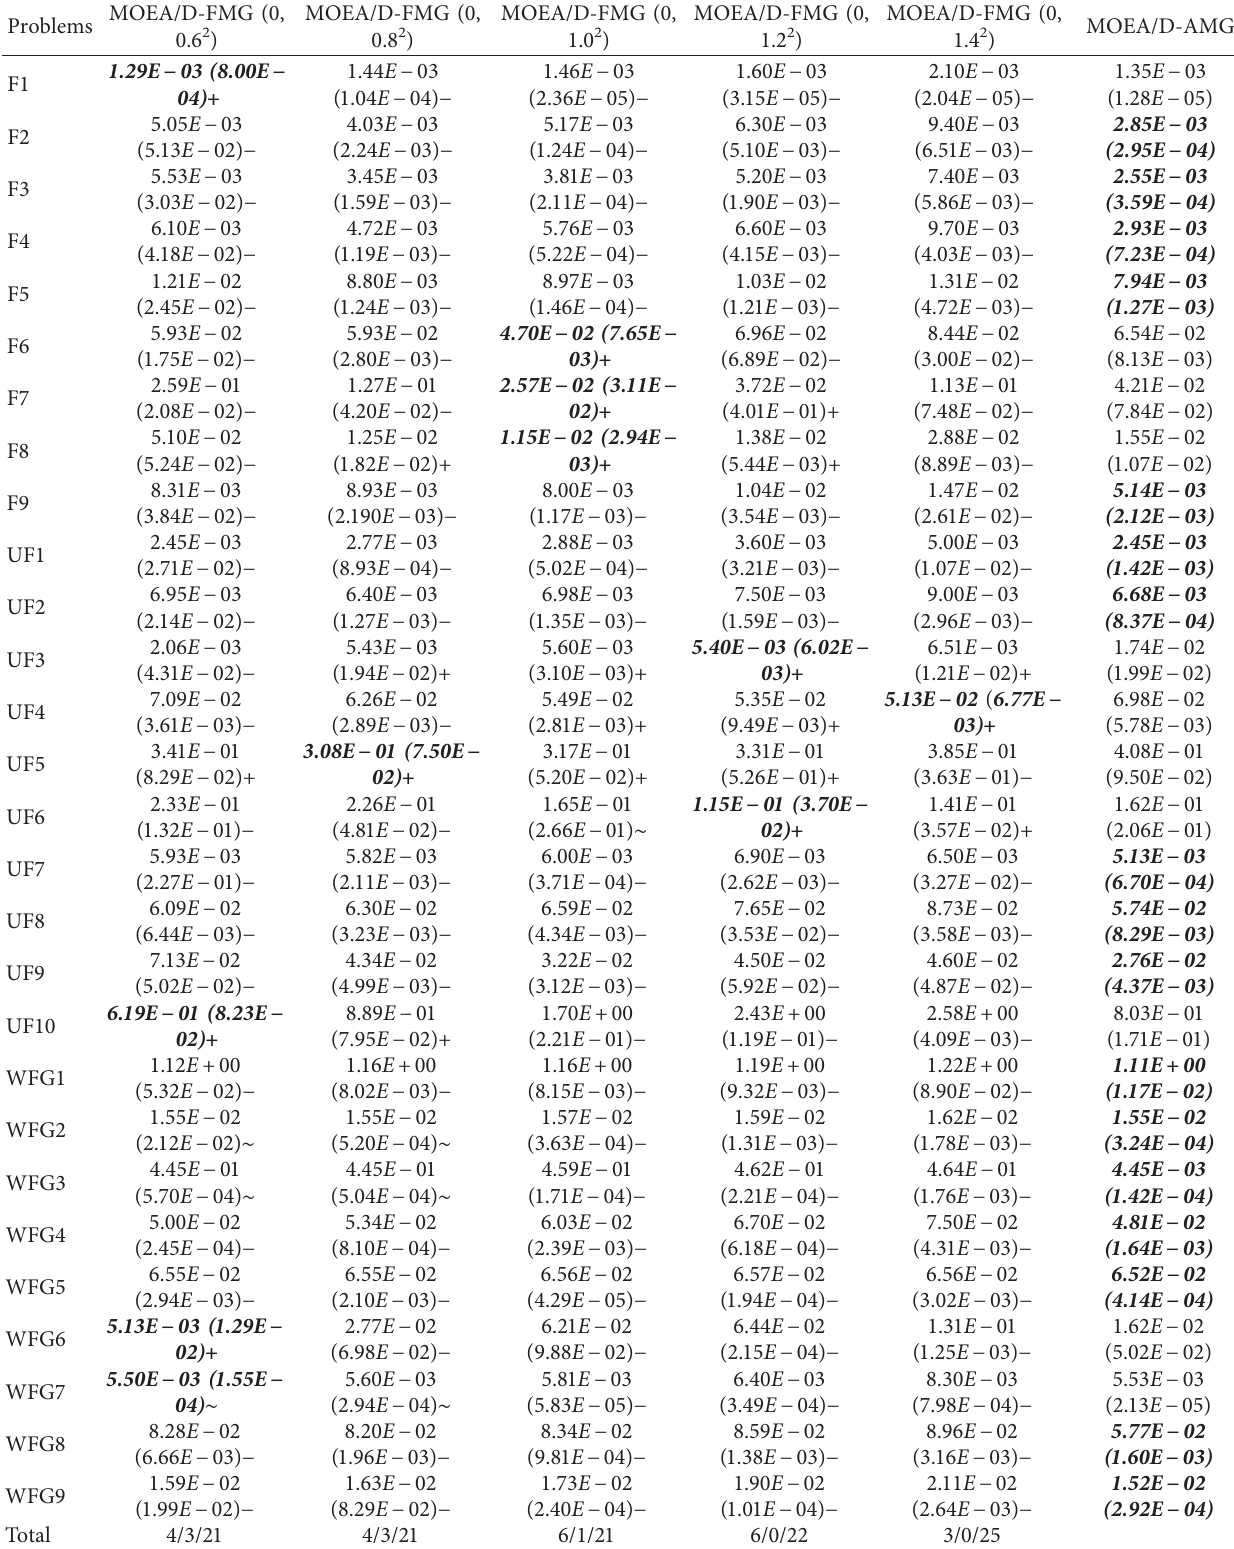
Table 4: Performance comparison of MOEA/D-FMG with various Gaussian distributions and MOEA/D-AMG in terms of the average IGD values and standard deviations on F, UF, and WFG